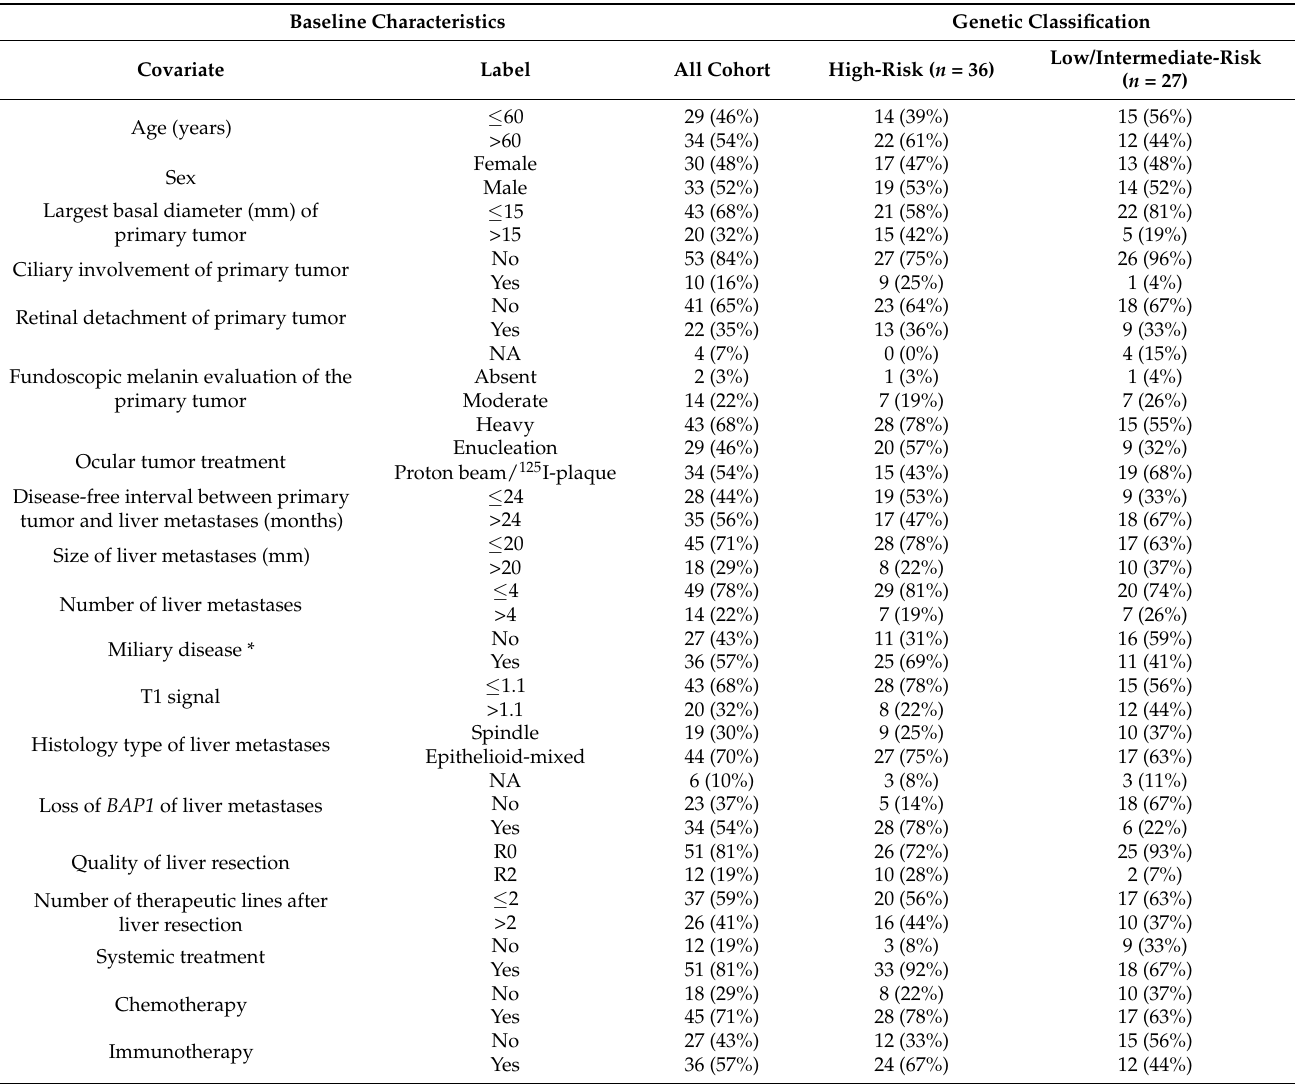
Table 1. Clinical, pathological, genetic, and radiological features of metastatic hepatic uveal melanoma cohort at liver resection